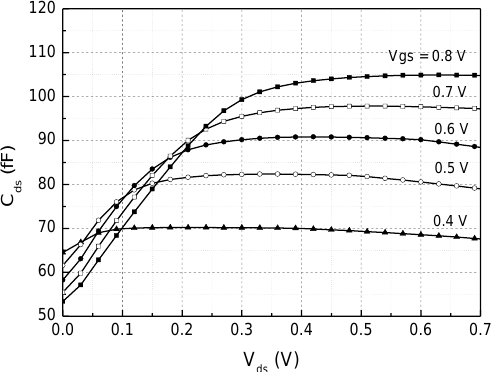
Figure 6. Drain-to-source capacitance C ds with respect to drain-to-source voltage V ds .